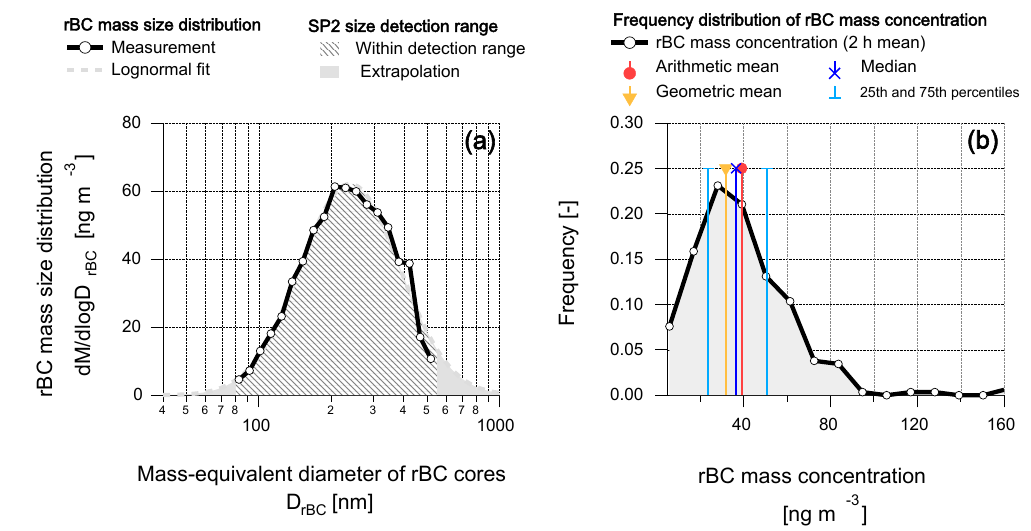
Figure 3. (a) Mass size distribution of rBC cores; (b) frequency distribution of 2h average rBC mass concentration